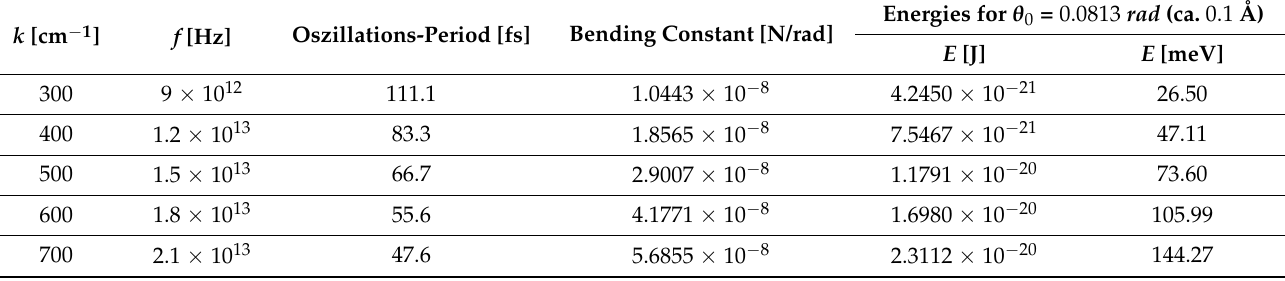
B T (T = 310 K). ( b ): When the positive K + approaches the